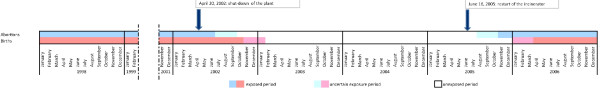
Operation periods of the municipal waste incinerator of Reggio Emilia, Italy, and corresponding exposure status of cohorts of births and of aborted foetuses undergoing a diagnosis of congenital anomaly during the 1998–2006 period.